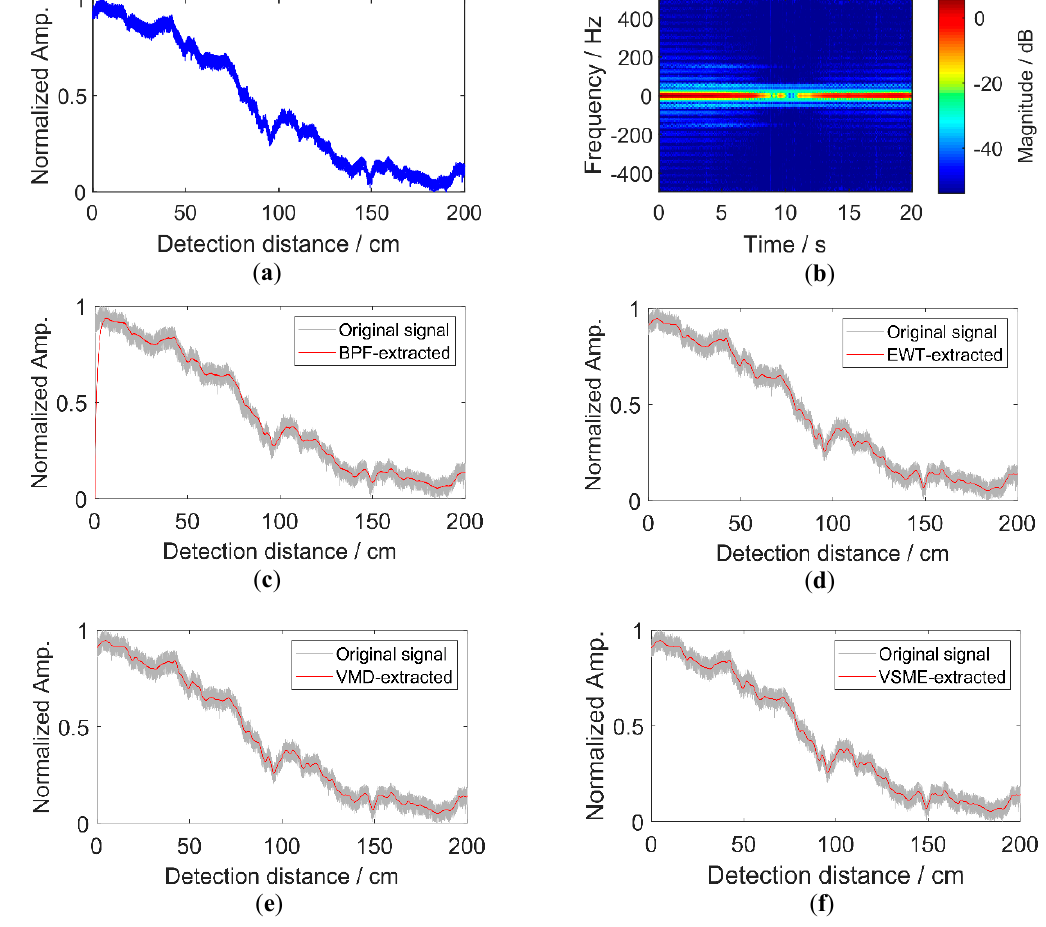
Figure 10. Analysis results for the Lab. 1 signal. ( a ) Acquired original magnetic field signal; ( b ) Fourier spectrum of original signal by STFT; ( c ) Pipeline defect signal extracted by band-pass filter; ( d ) Pipeline defect signal extracted by EWT; ( e ) Pipeline defect signal extracted by VMD; ( f ) Pipeline defect signal extracted by VSME.